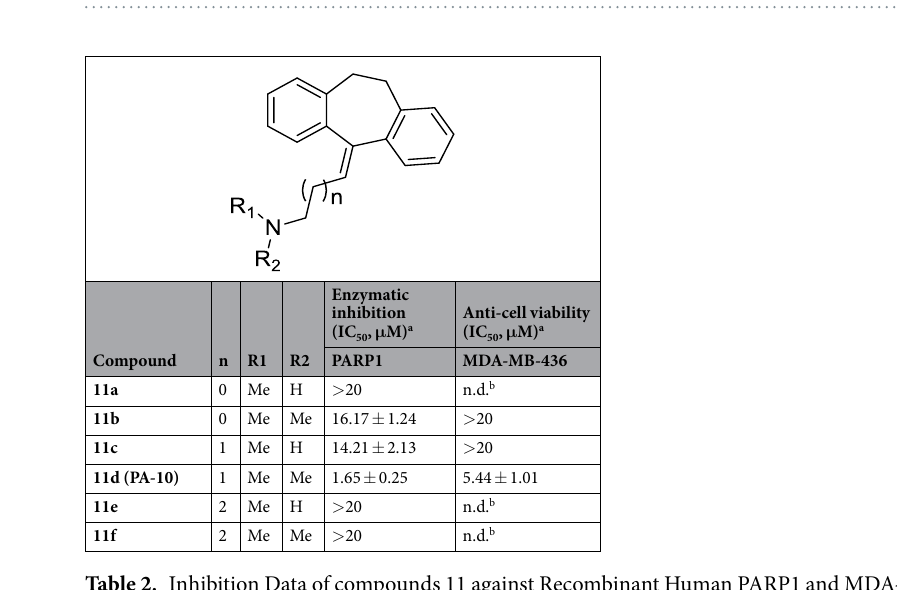
Figure 8. Synthesis of 3-(dimethylamino)propylidene)-6,11-dihydrodibenzo[b,e]oxepinderivatives. Reagents and conditions: ( a ) DMF, MeONa, 120 °C; then, PPA, AcOH, 75 °C; ( b ) THF, 10, n-BuLi; ( c ) CH 2 Cl 2 , SOCl 2 , r.t.; ( d ) CH 2 Cl 2 , amine.